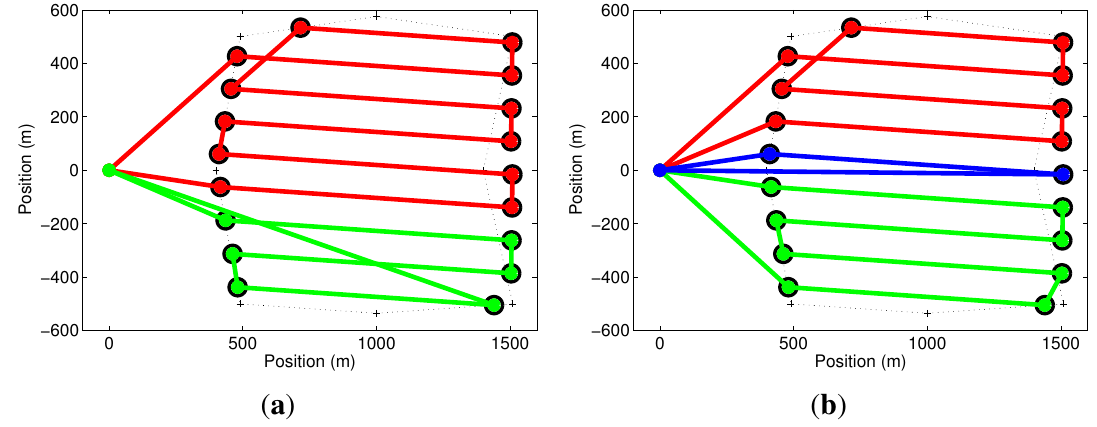
Figure 9. ( a ) Optimal solution for the problem in Figure 8 when the four UAVs available are operated by a single person and the cumulative setup time is considered. Only two UAVs were selected by the method; ( b ) Effect of constraint in Equation (8) when the UAVs’ battery life is reduced and a third UAV is necessary to complete the task.